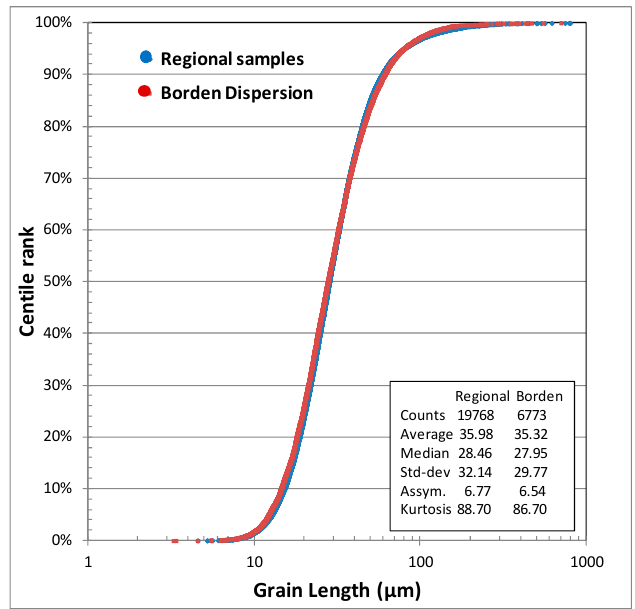
Figure 12. Cumulative size distribution curve of gold grain recovered from the dispersion train down-ice of Borden gold occurrence [13], versus the size distribution in the neighboring regional survey. Both populations are overlapping on the diagram, suggesting that fine gold grains are not dispersed further than the large one in the course of the glacial sedimentation process.